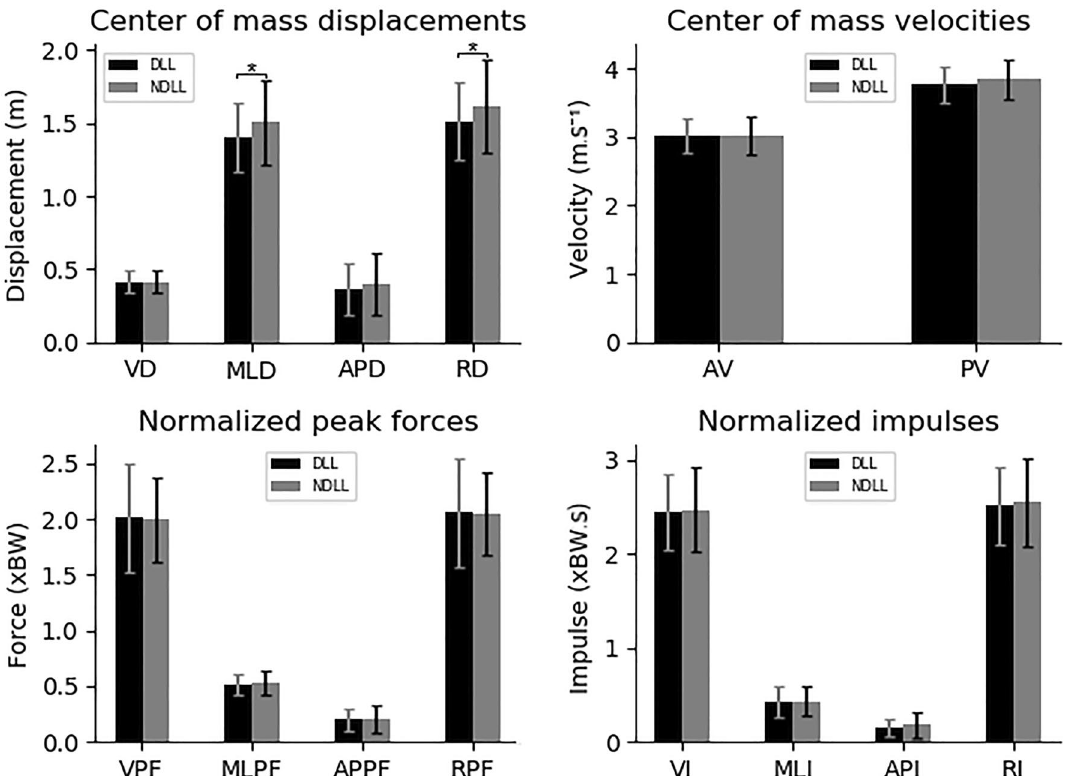
Figure 3. Average and standard deviation of the dive variables with the trials divided according to the lower limbs laterality independently of the rule the trials were performed. *p < 0.05. DLL, trials to the side of the dominant lower limb; NDLL, trials to the side of the non-dominant lower limb; VD, vertical displacement; MLD, mediolateral displacement; APD, anteroposterior displacement; RD, resultant displacement; AV, average velocity; PV, peak velocity; VPF, vertical peak force; MLPF, mediolateral peak force; APPF, anteroposterior peak force; RPF, resultant peak force; VI, vertical impulse; MLI, mediolateral impulse; API, anteroposterior impulse; RI, resultant impulse; m, meters; s, seconds; xBW, times body